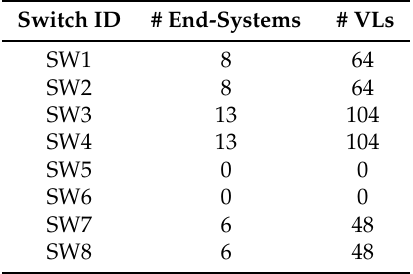
Table 4. Description of the AFDX configuration.